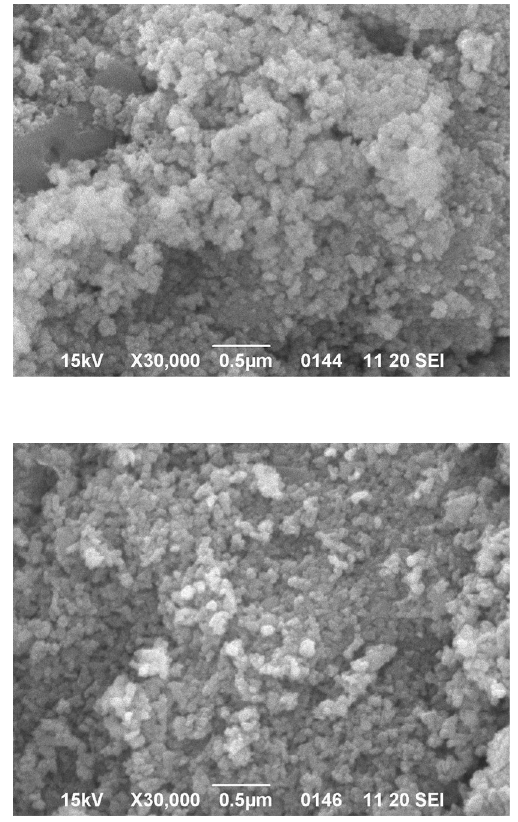
Fig. 7 SEM morpholgy of CuO Nanoparticles